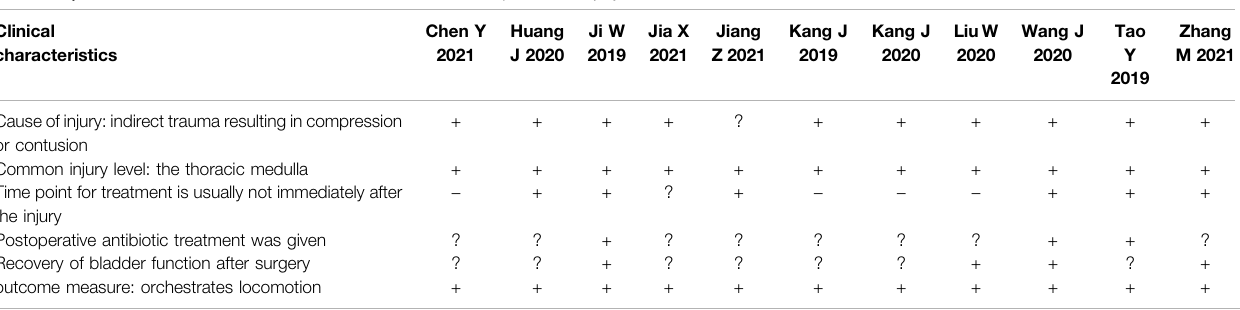
TABLE 3 | Evaluation of the relevance of clinical characteristics of spinal cord injury. Clinical